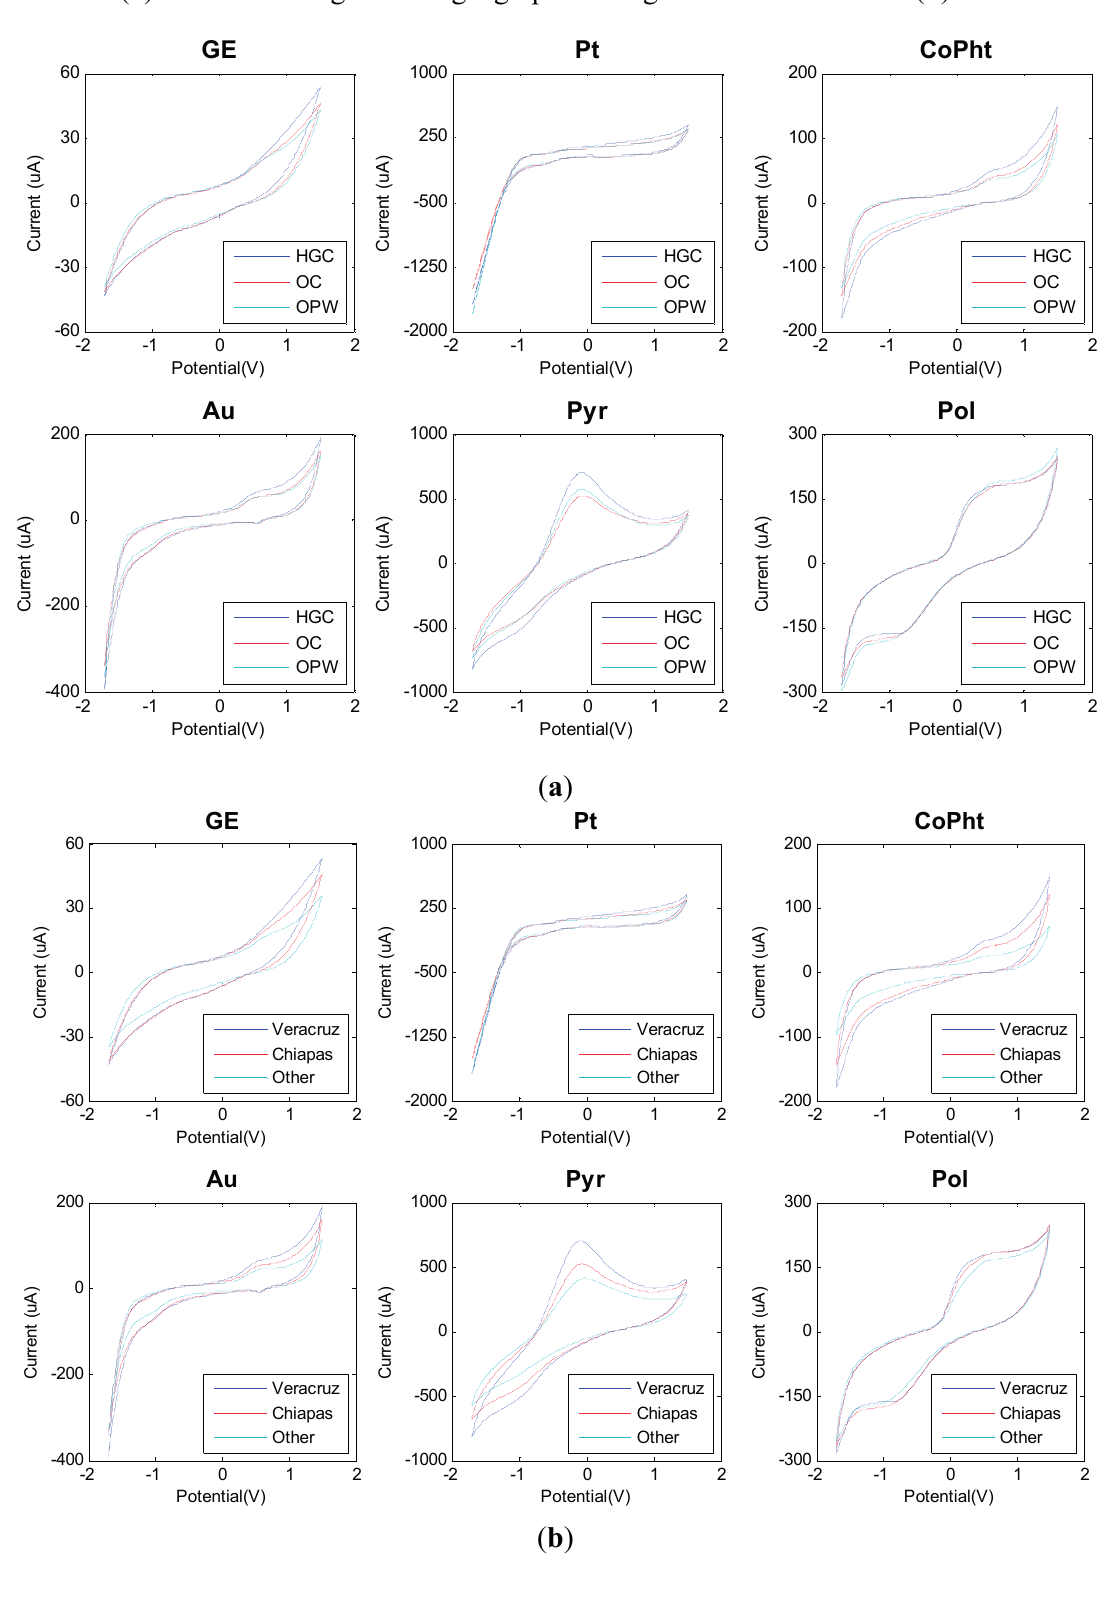
Figure 2. Recorded voltammograms from Graphite Epoxy (GE), Platinum nanoparticle (Pt), Cobalt II phthalocyanine (CoPht), Gold nanoparticle (Au), Polypirrole (Pyr) and Polyaniline (Pol) sensors for three different coffee samples. Voltammograms for growing conditions are shown in ( a ) and voltammograms for geographical origin can be observed in ( b